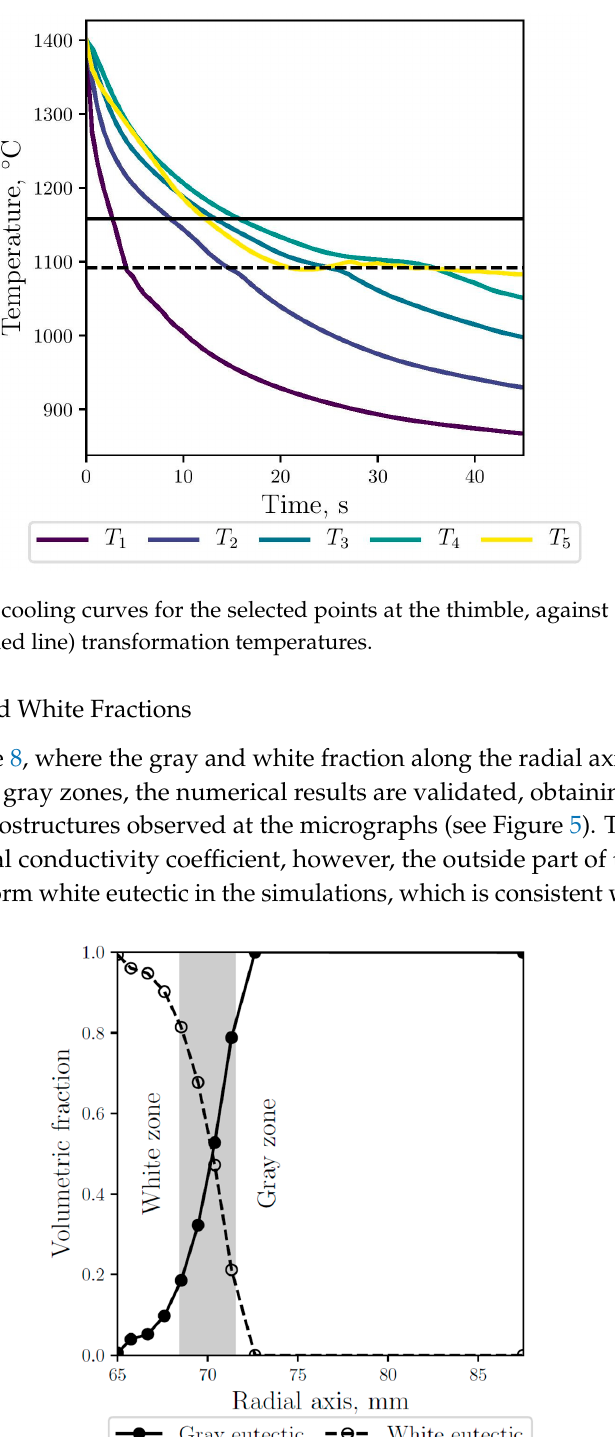
Figure 8. Simulated gray (continuous line) and white (dashed line) eutectic fractions along the radial axis. The gray area represents the experimentally observed transition zone.